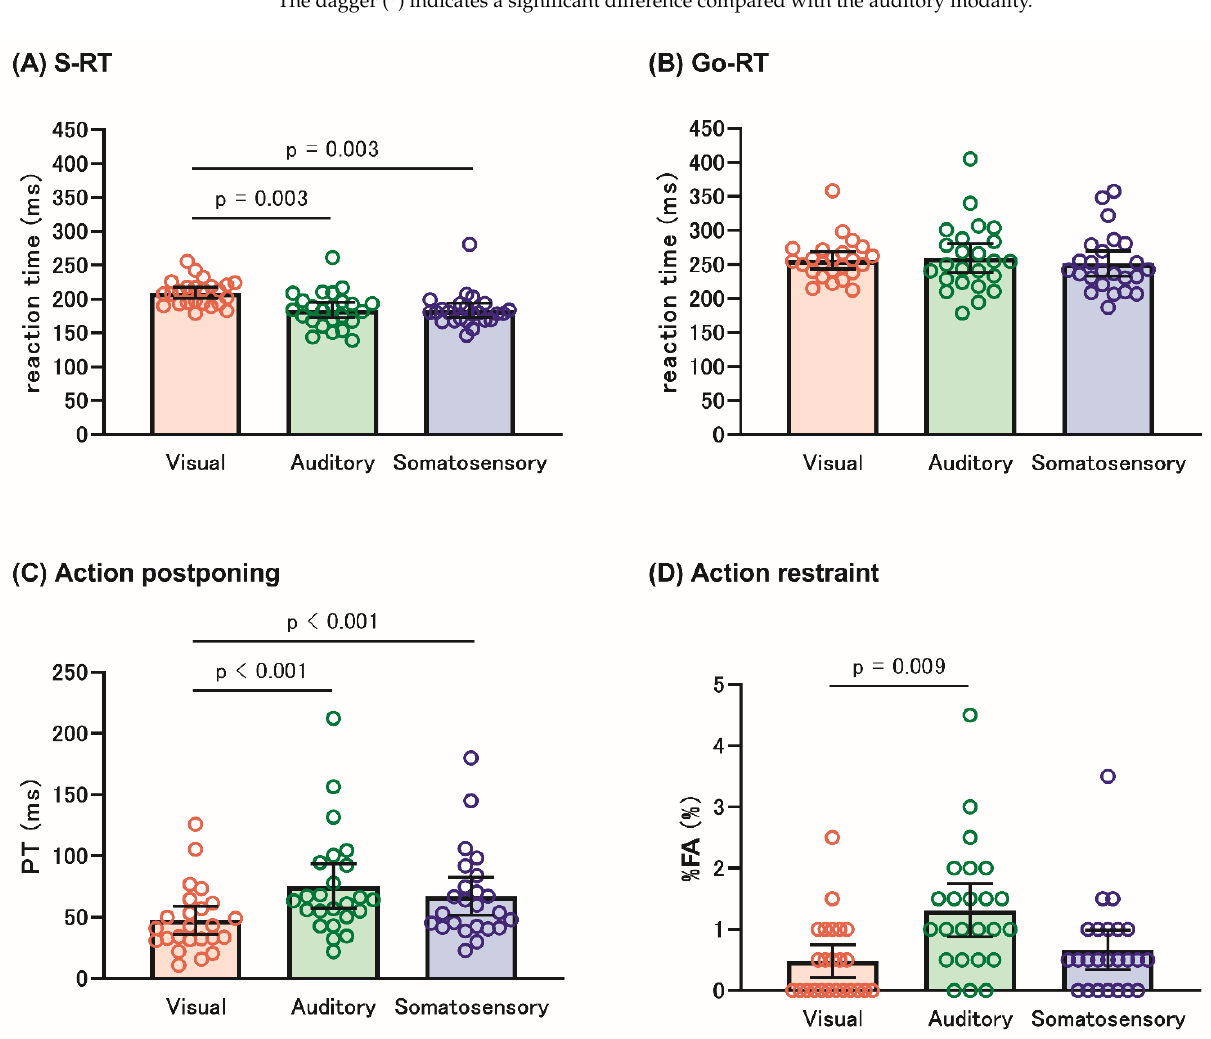
FA, false alarms. Note. The asterisk (*) indicates a significant difference compared with the auditory and somatosensory modalities. The dagger ( † ) indicates a significant difference compared with the auditory modality.